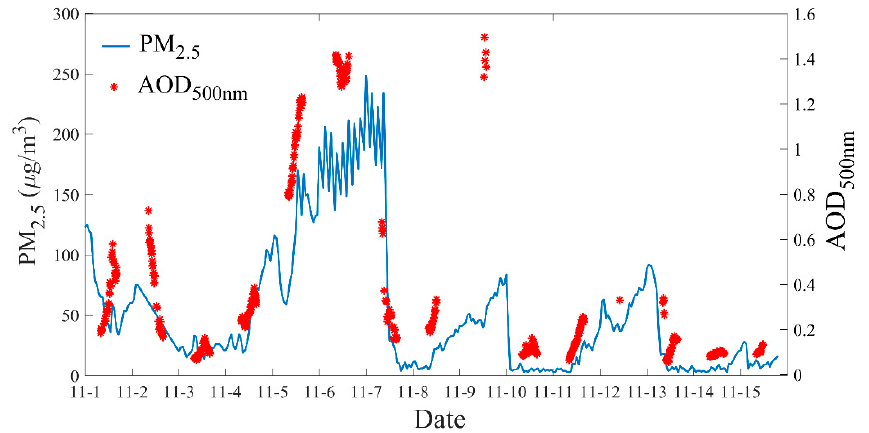
Figure 2. The aerosol optical depth (AOD) and PM 2.5 (particulate matter with aerodynamic diameter less than 2.5 μ m) during the field experiment. The AOD data are from the aerosol robotic network (AERONET) Beijing_RADI site, and the PM 2.5 data are from the Beijing Municipal Environmental Protection Monitoring Center.